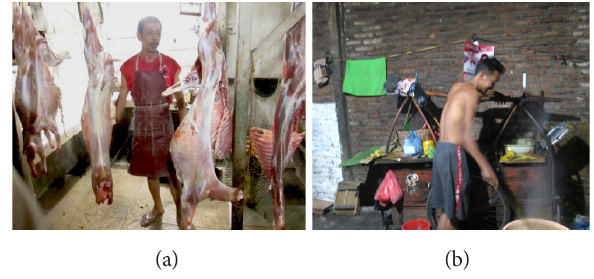
Figure 2. (a) The process of pengkeletan